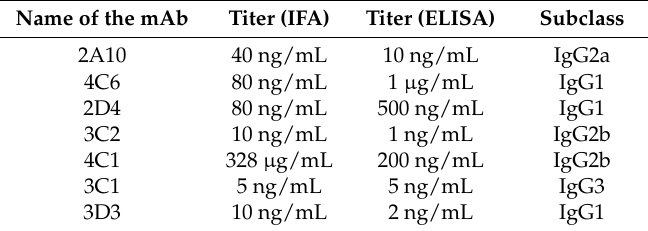
Table 1. The titers of the PfCSP ‐ specific mAbs*.